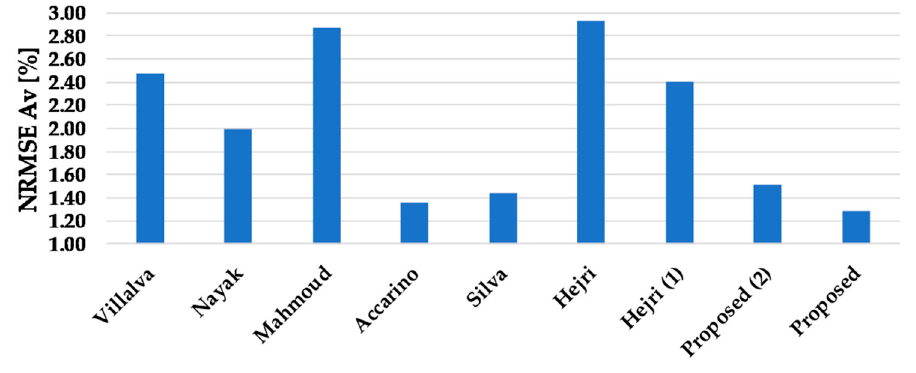
Figure 8. Normalized error pattern for all the examined methods for different solar irradiance values.